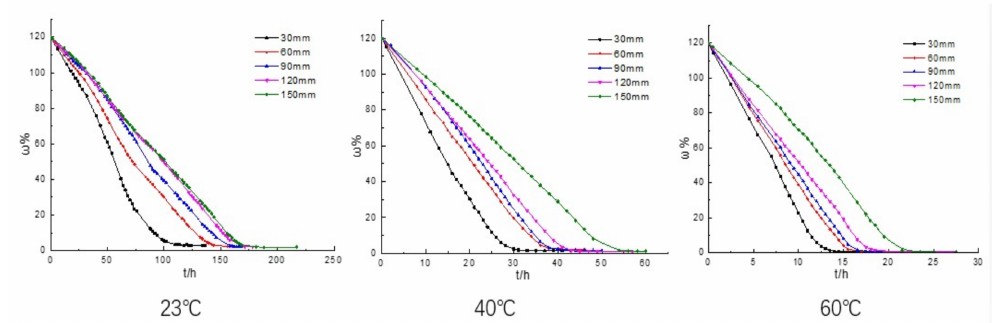
Figure 6. The relationship between the diameter and moisture content of different samples at different temperatures.